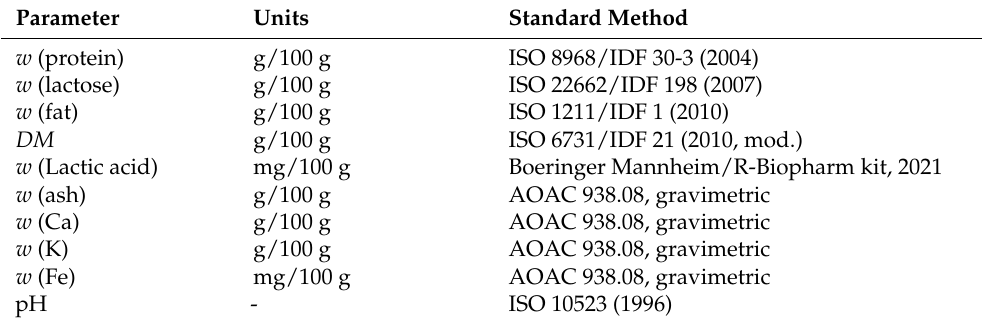
Table 2. The standard methods used for the chemical analyses.